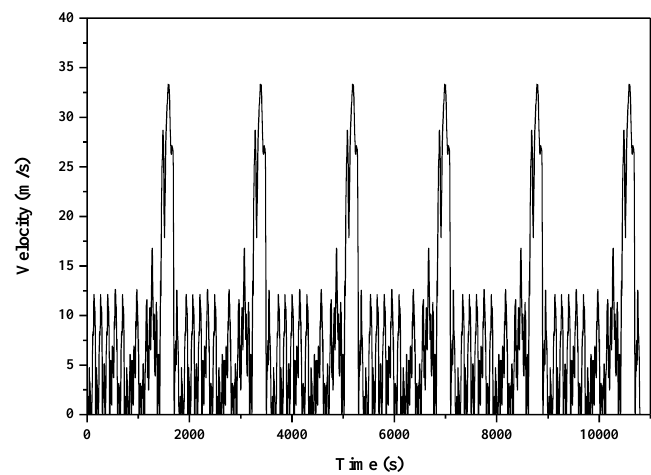
Figure 14. Vehicle velocity within the real driving cycles in the study.